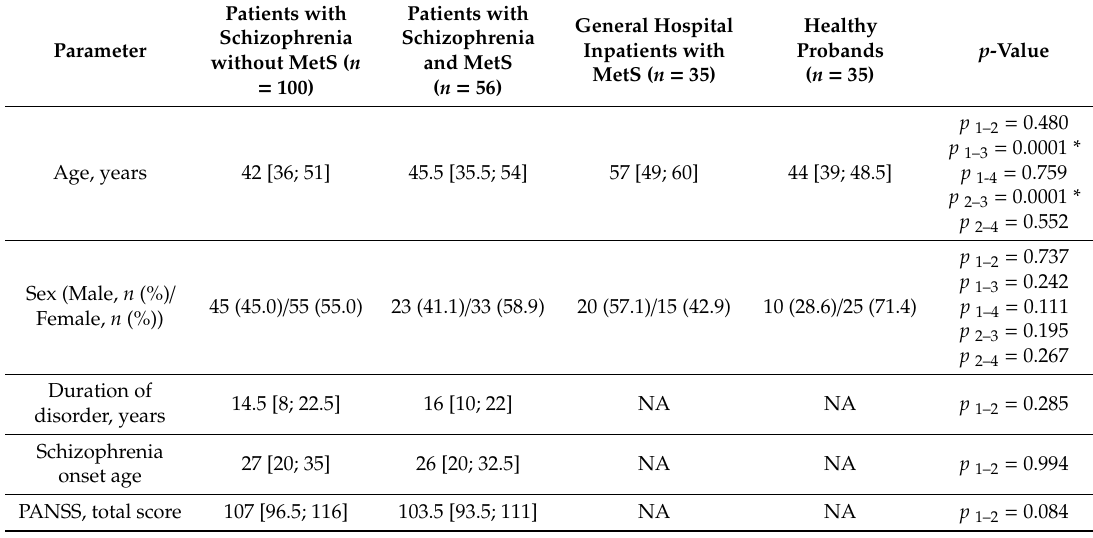
Table 1. Demographics and baseline parameters of study